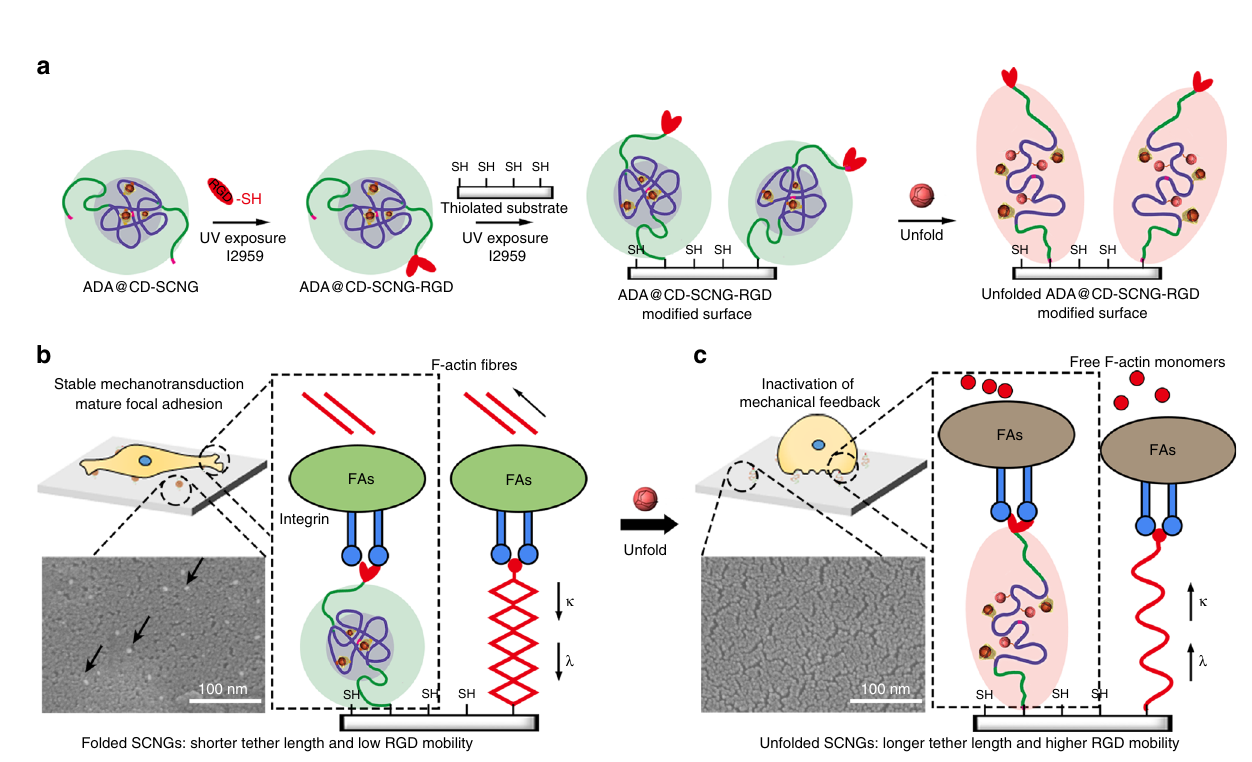
Fig. 4 The effect of SCNG-based RGD linkers unfolding on the adhesion and spreading of stem cells. a Synthesis and substrate conjugation of dynamic supramolecular ADA@CD-SCNG-RGD through a click reaction. b The folded ADA@CD-SCNGs on a glass substrate can be observed as particle-like structures (white dots) by SEM. The ADA@CD-SCNG-RGD linkers in the folded state provide a short RGD tether length ( λ ) and limited mobility ( κ ), which favour the formation of mature focal adhesions (FAs) and the spreading of cells on the substrate. c The unfolding of the SCNGs resulted in the disappearance of these white dots, and the unfolding of the ADA@CD-SCNG-RGD linkers led to an increased RGD tether length ( λ ) and mobility ( κ ), thereby hampering the formation of FAs and the spreading of cells. The scale bars are 100